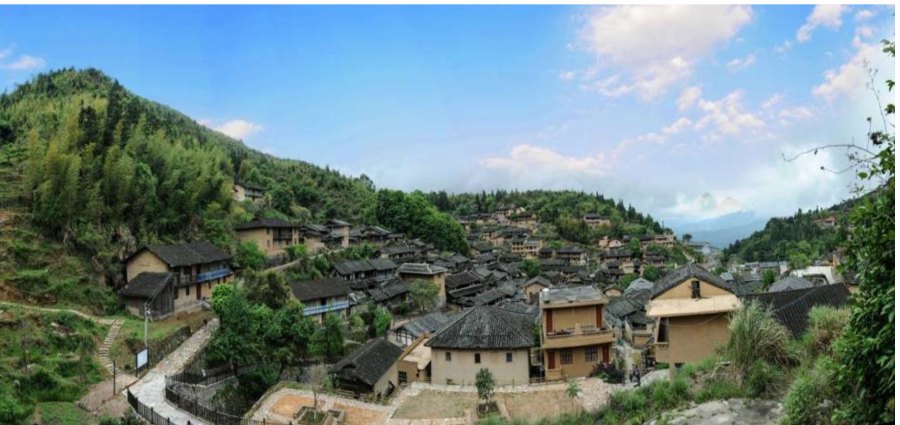
Figure 2. Guifeng